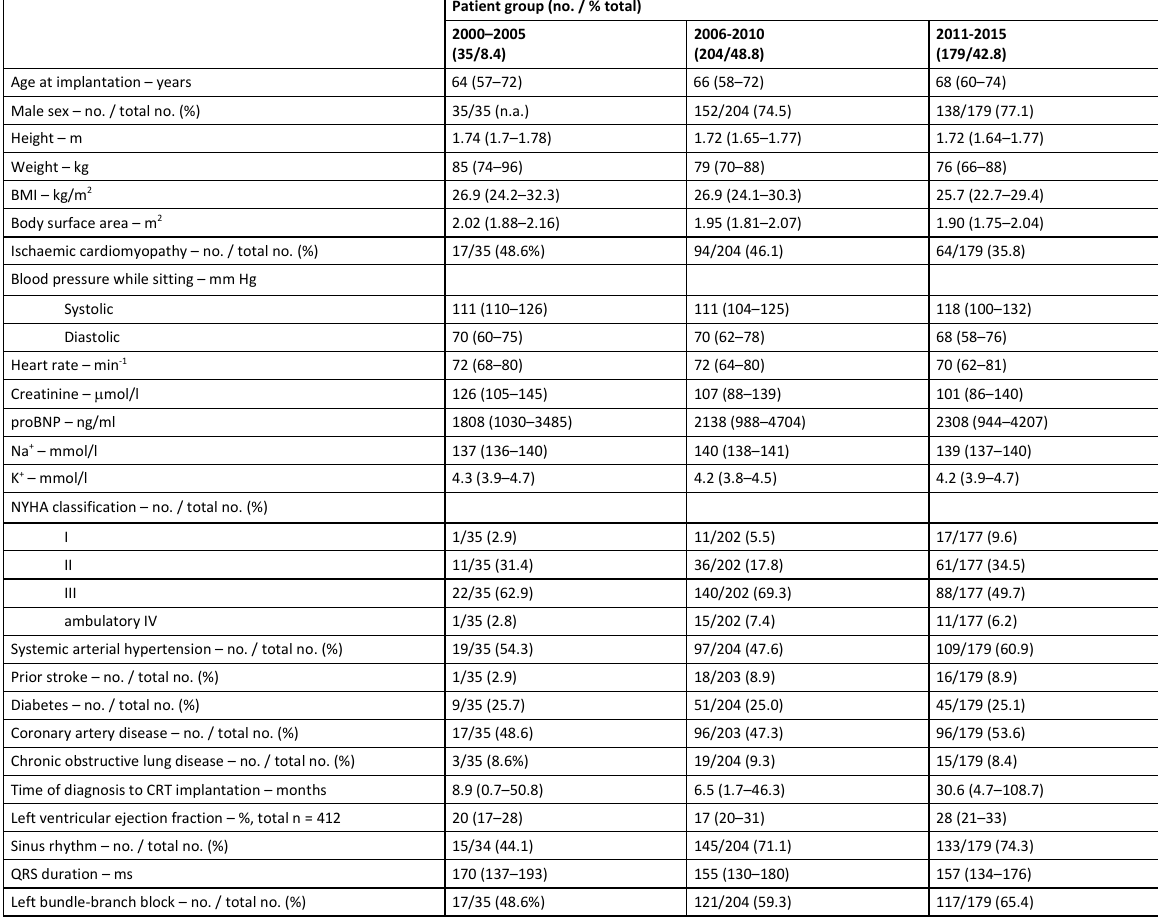
Table S1: Patient characteristics at baseline stratified according to the time period of cardiac resynchronisation therapy device implantation.